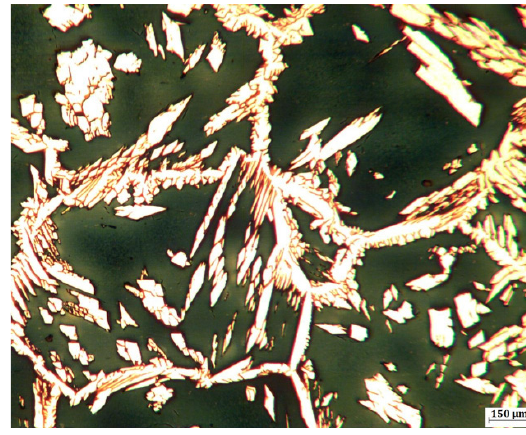
Figure 13. Microstructure from the 2205 DSS HTHAZ (2.6 kJ mm –1 ).